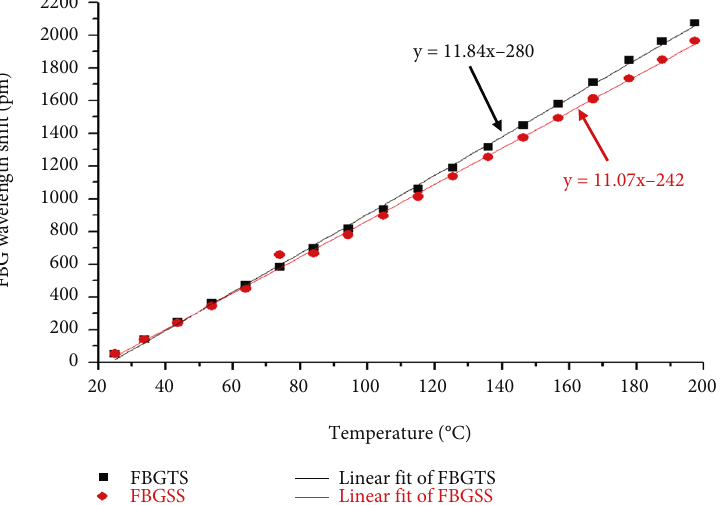
Figure 2: Temperature sensitivity of the FBGTS and FBGSS.